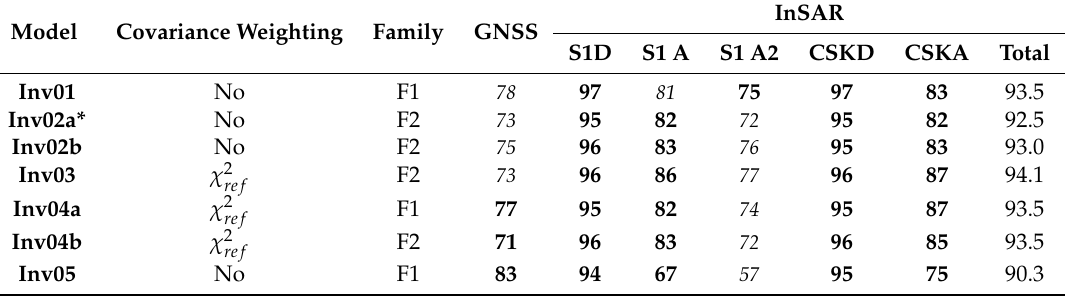
Table 1. Covariance weigthing ( Cd is defined based on Equations (4) and (5), ’No’ means that no specific additional weighting is applied whereas χ 2 means that the misfit is scaled by the misfit of the ref null model), geometry of the best model (for families definition see Section 5.1.1) and % of Explained data (see Equation (9)) computed for each interferogram spanning the eruption. Numbers in bold are for data used in the inversion, values in small italics are computed a posteriori for data not used in the inversion. Inv01 was computed with InSAR data S1 A2, which does not cover the pre-eruptive period. Inv. 01 to 03 were computed without including the GNSS data. Inv02a* is the preferred model presented in Smittarello et al.